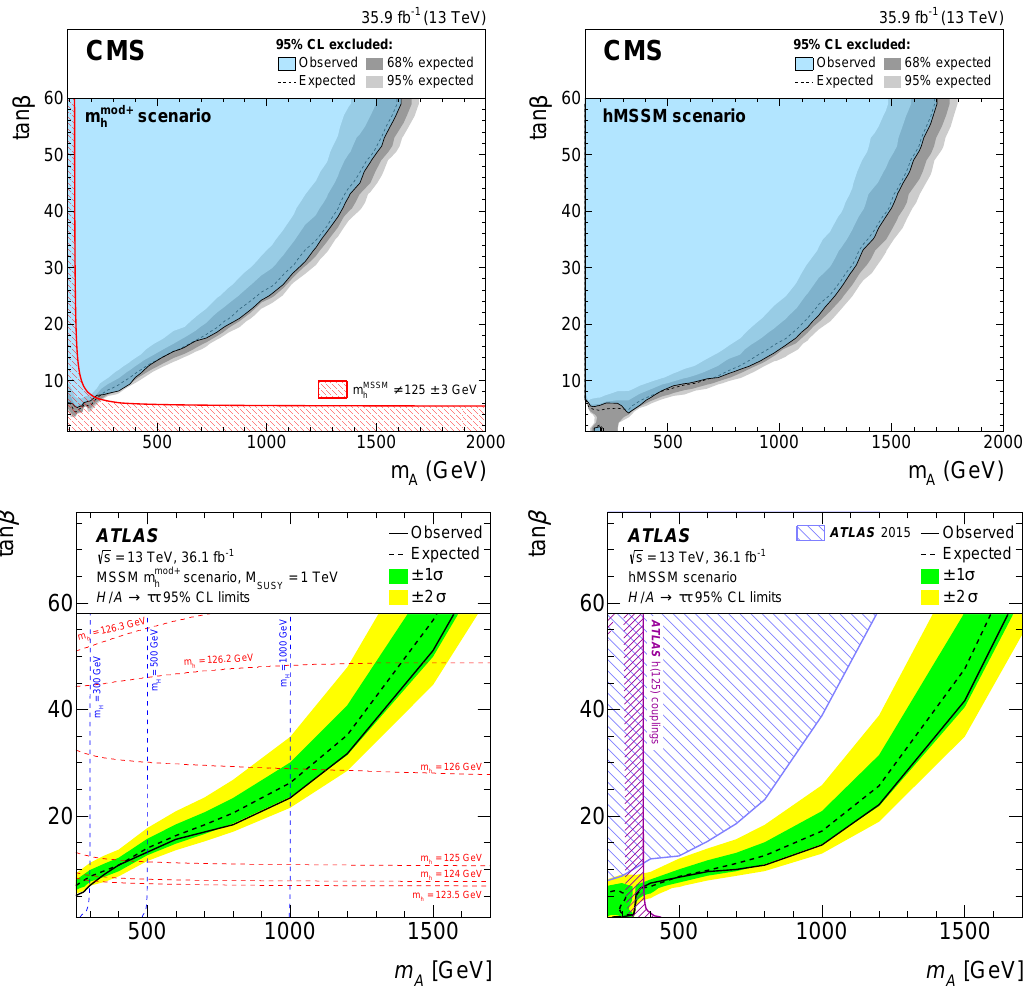
− tan β plane for the (left) A h